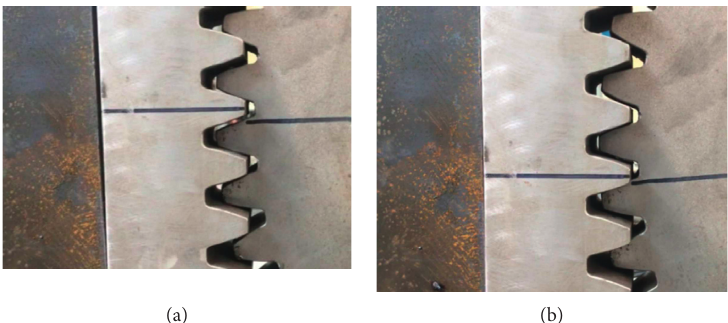
Figure 9: Loading process for Case 4. (a) Partial view of the straight teeth contact (while pulling up). (b) Partial view of the straight teeth contact (while pressing down).